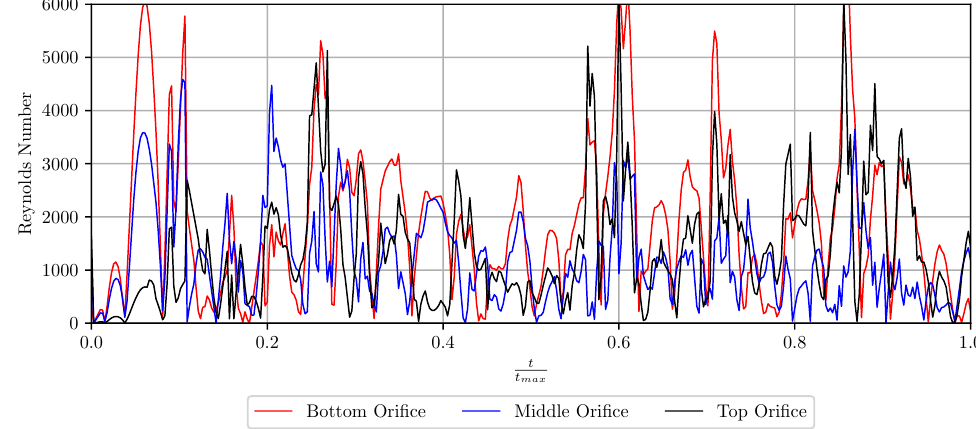
Figure 10. Reynolds number of flow in each orifice over time of violent slosh test case.